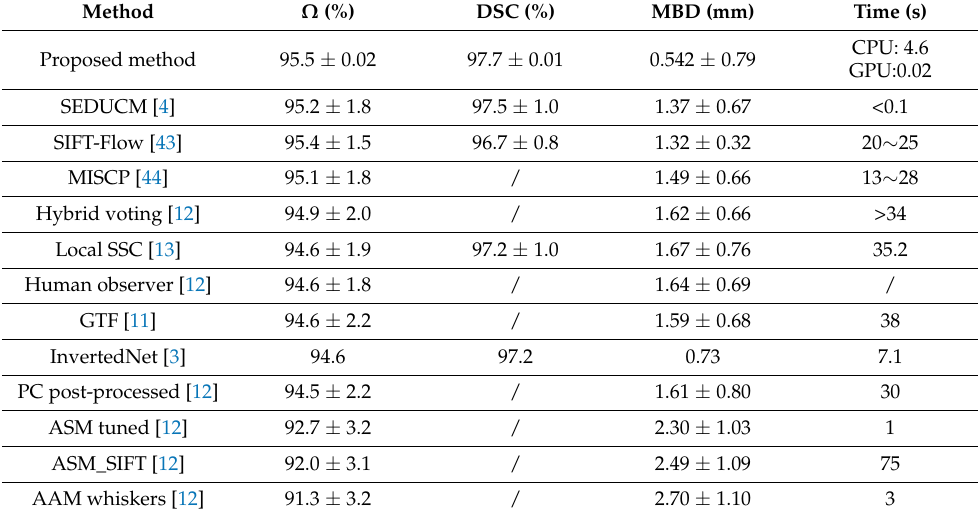
Table 3. Comparison of lung field segmentation methods on JSRT